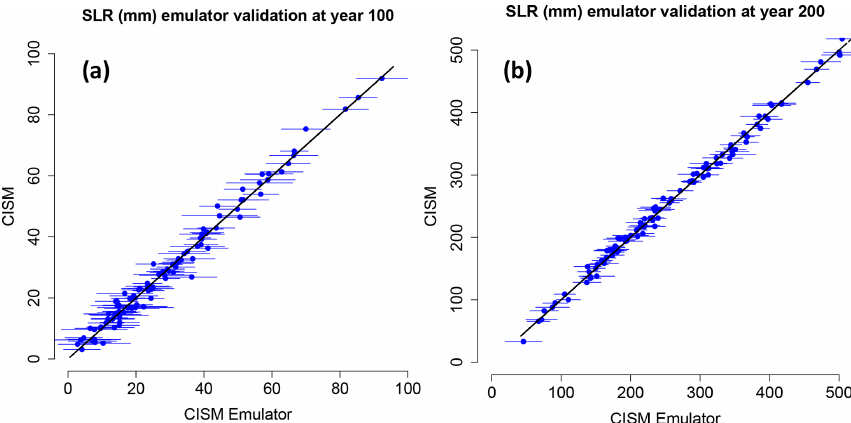
Figure 8. Emulator validation: true (CISM) vs. predicted (CISM Emulator) SLR values for year 100 (a) and 200 (b) . Solid black line shows 1 : 1 correlation. Correlation coefficients are 0.98 and 0.99, respectively. Note the different x and y scales for (a) and (b) . Error bars go from − 2 σ to + 2 σ